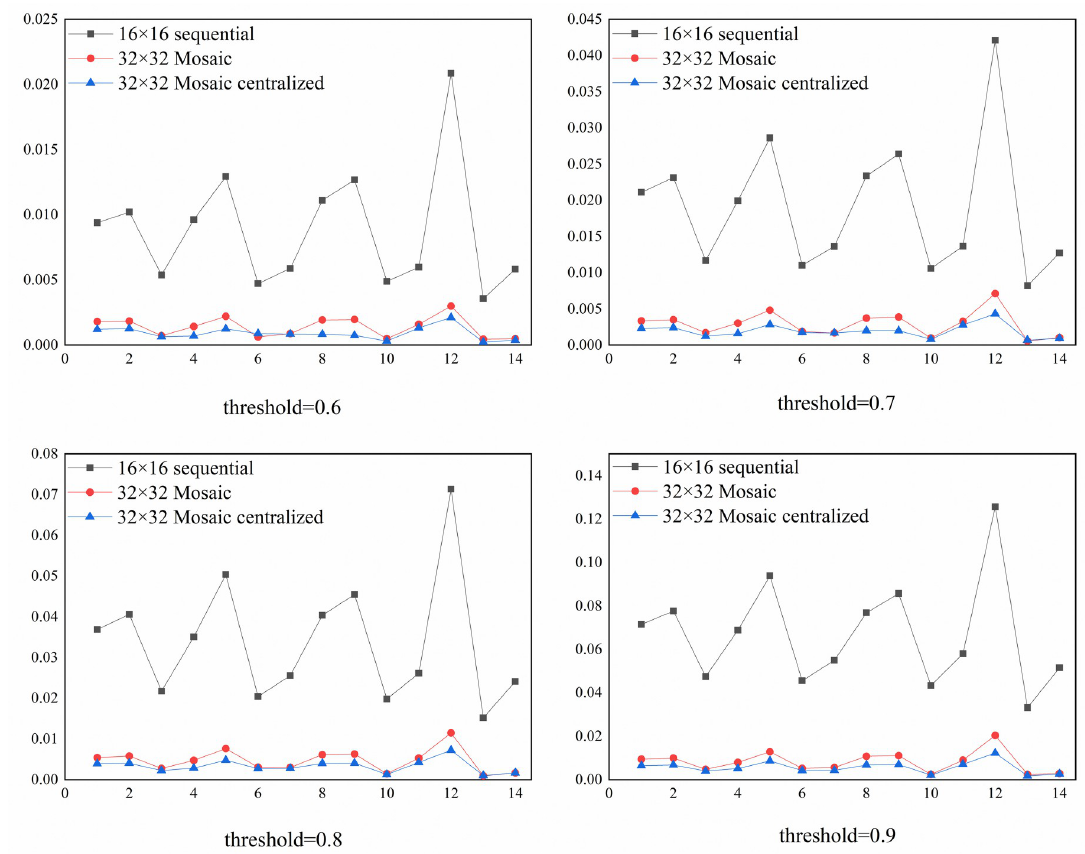
Fig 12. Comparison of UR for the 11-bit CAN ID under different